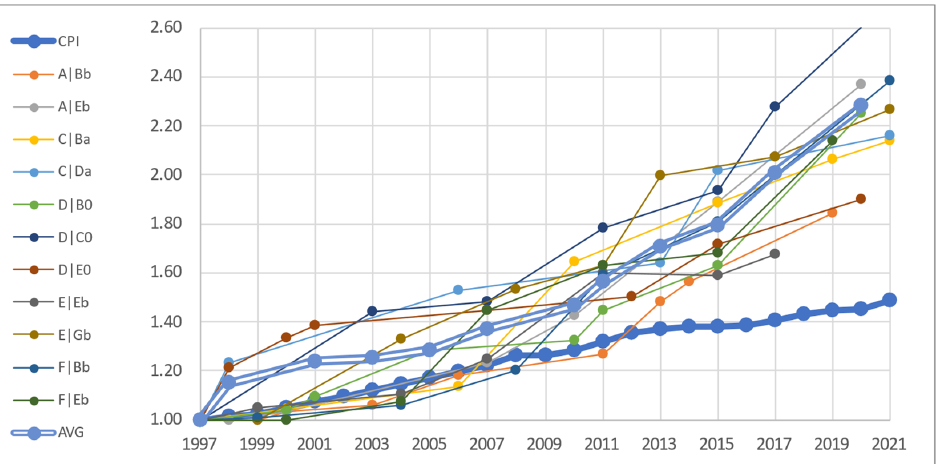
Figure 2. Eurozone harmonized index of consumer prices (HICP) and Germany’s tractor family MSRP evolution relative to 1997.